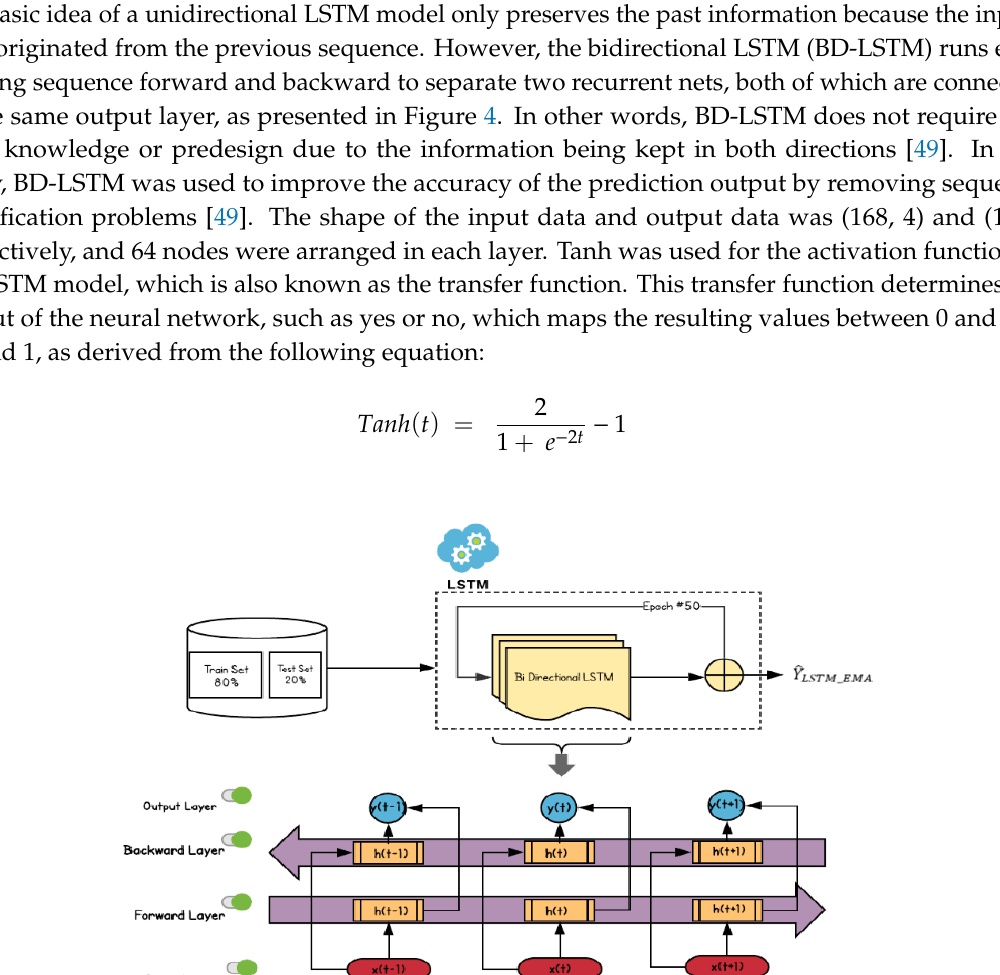
Figure 3. Data processing (training and testing procedures) of the proposed framework.